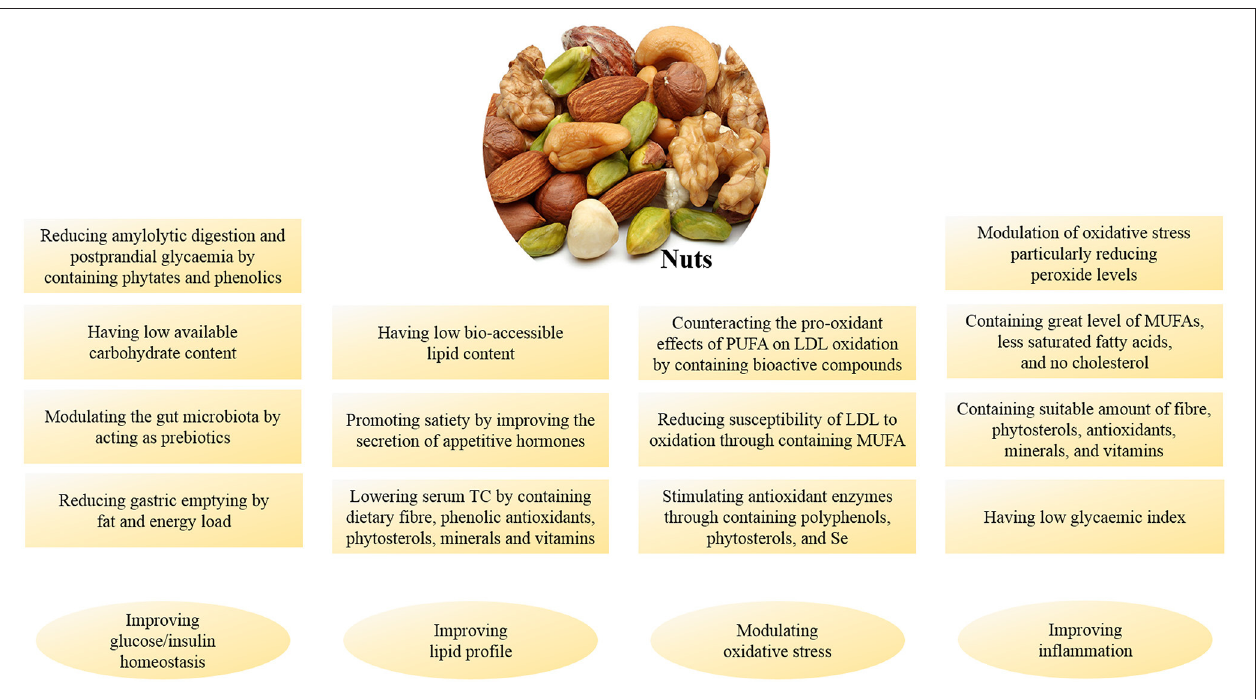
FIGURE 2 | A summary of nuts mechanisms of action in controlling metabolic